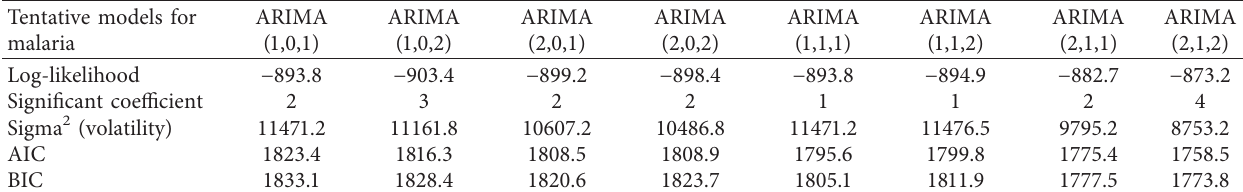
Table 1: Estimation of the ARIMA model.